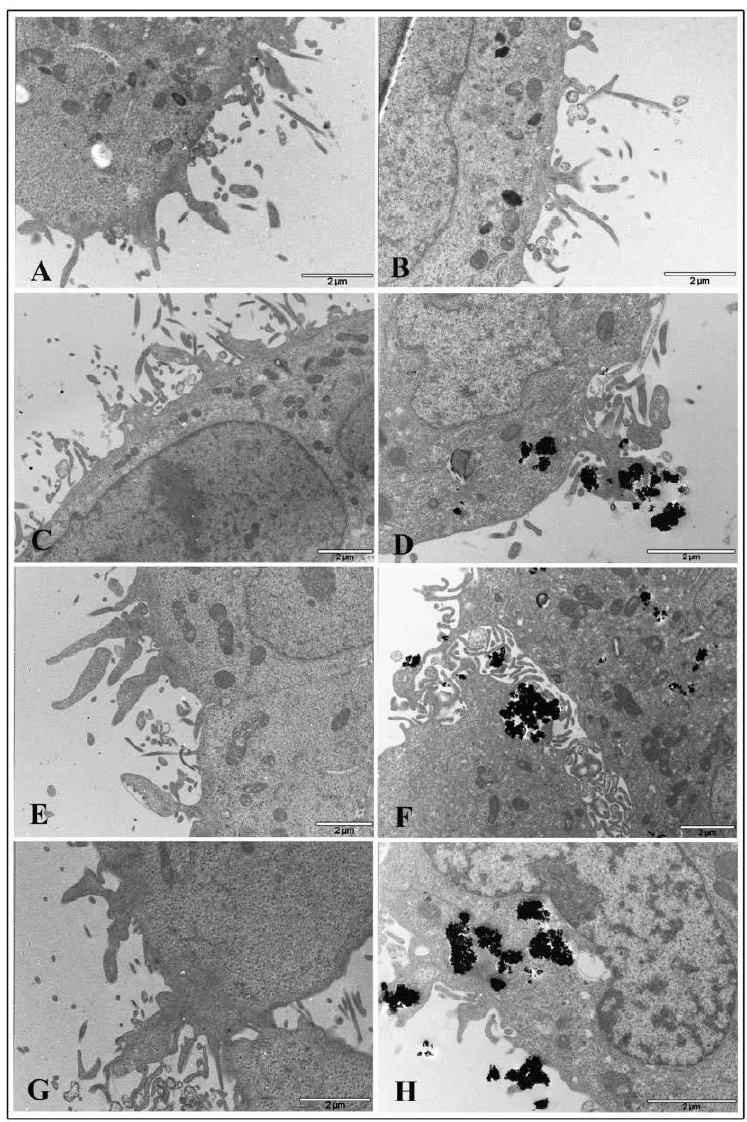
Figure 7. Transmission electron microscopy micrographs of HT-29 cells following exposure to TiO 2 NPs. Representative images of control untreated cells ( A , B ) following 1 μ g/cm 2 treatment at 2 h ( C ), 6 h ( E ), and 24 h ( G ) time exposure, and after 20 μ g/cm 2 treatment at 2 h ( D ), 6 h ( F ), and 24 h ( H ) time exposure.